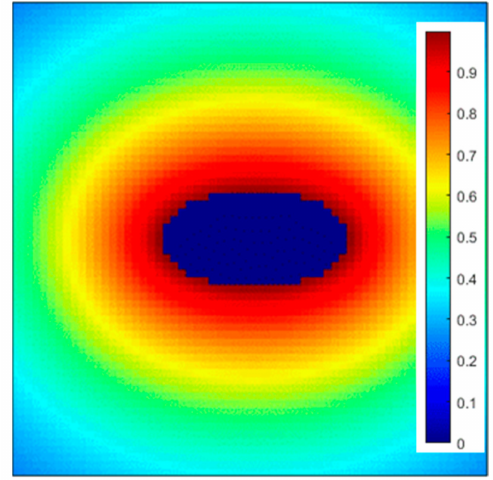
Figure 1. Wall distance field of an ellipse with AR = 4.